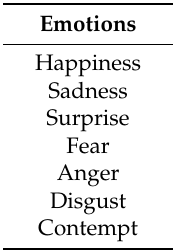
Table 2. FACS Emotions.